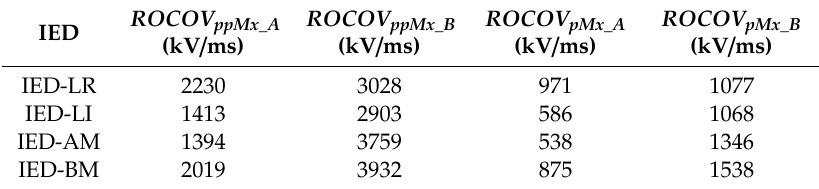
Table 3. Maximum ROCOV values used with Equation (4).